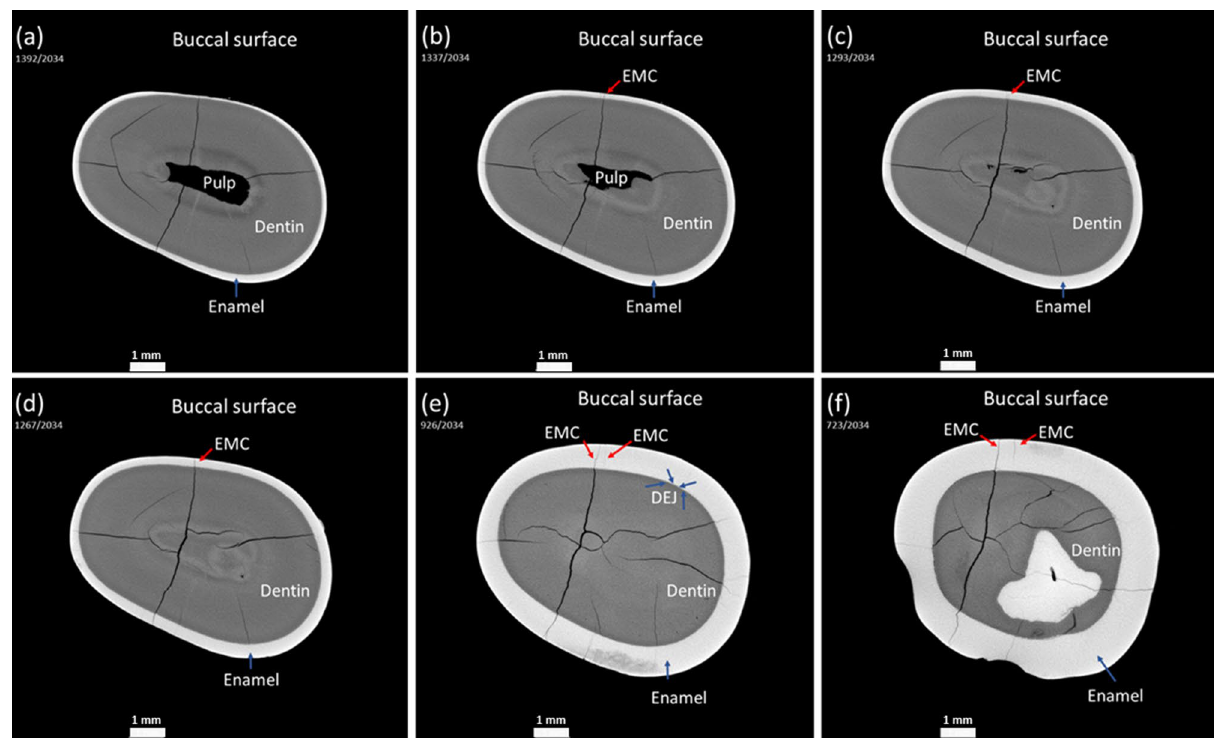
Figure 6. The path of the longest EMC invisible on the outer buccal surface as it extends from ( a , b ) the cervical ( c , d ) to the middle and ( e , f ) occlusal parts of the tooth crown. Anatomical tooth structures (pulp, dentin, DEJ, enamel, EMC) are marked.